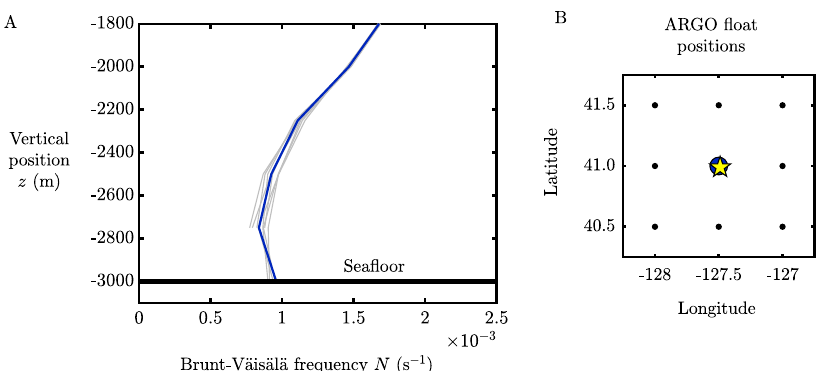
Fig. 8 Pro fi le of the Brunt-Väisälä frequency N as a function of height from the sea fl oor. The pro fi les are provided by the dataset of 50 . ( A ) shows the Þ ∂ ρ = ∂ z (cid:3) 1 = 2 as a function of vertical position, where g ≈ 9.8 m s − 2 and ρ ≈ 1027 kg m − 3 . The blue curve shows the pro fi le closest to pro fi le of N ¼ ½(cid:2)ð g = ρ 0 0 the Northern Escanaba (NESCA) lava fl ow. The pro fi les for the 8 surrounding pro fi les (on a grid with a resolution of 0.5 degrees) are also shown as gray curves, illustrating the near-uniformity of the pro fi les of N over the entire region. The plots show that the value N ≈ 10 − 3 s − 1 characterizes the abyssal ocean, which we utilized in our inversion for the rate of heat transfer Φ in Eq. (4). ( B ) shows a plan-view of the sampled coordinates, with the position of the NESCA lava fl ow indicated by the